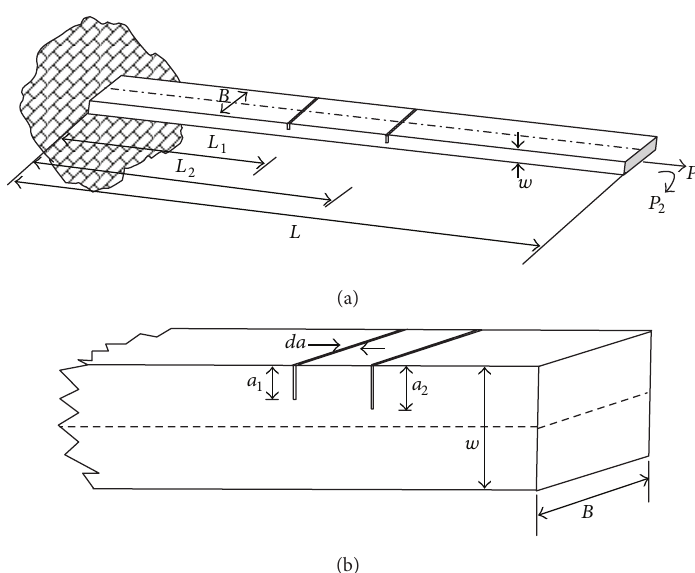
Figure 1: Geometry of beam. (a) Cantilever beam. (b) Cross-sectional view of the beam.